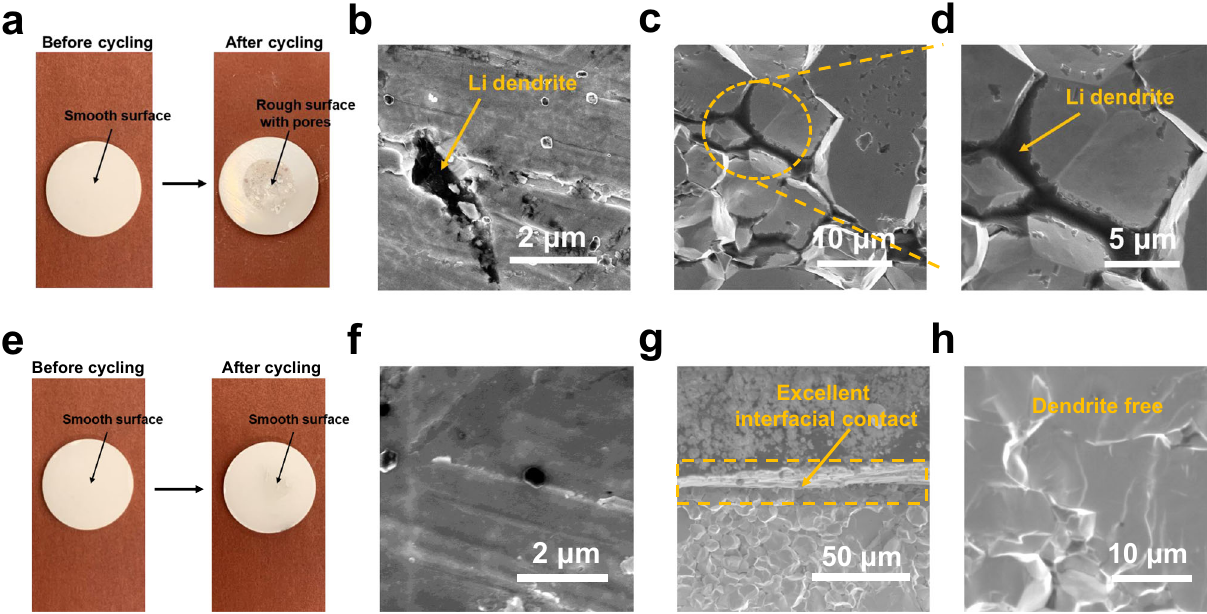
Fig. 5 Li dendrite growth in the bare LLZTO and the PAA-modi fi ed LLZTO. a Optical surface morphologies of an LLZTO pellet before and after cycling. b Top-view and c , d cross-sectional SEM images of an LLZTO pellet after short circuiting. e Optical surface morphologies of an LLZTO@EBS pellet before and after cycling. f Top-view SEM image of an LLZTO@EBS pellet after cycling at 0.2 mA cm − 2 for 1000 h. g Cross-sectional SEM image of the LLZTO@EBS/Li interface, and h cross-sectional SEM image of an LLZTO@EBS pellet after cycling at 0.2 mA cm − 2 for